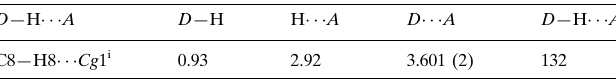
Hydrogen-bond geometry (A˚ , (cid:1)